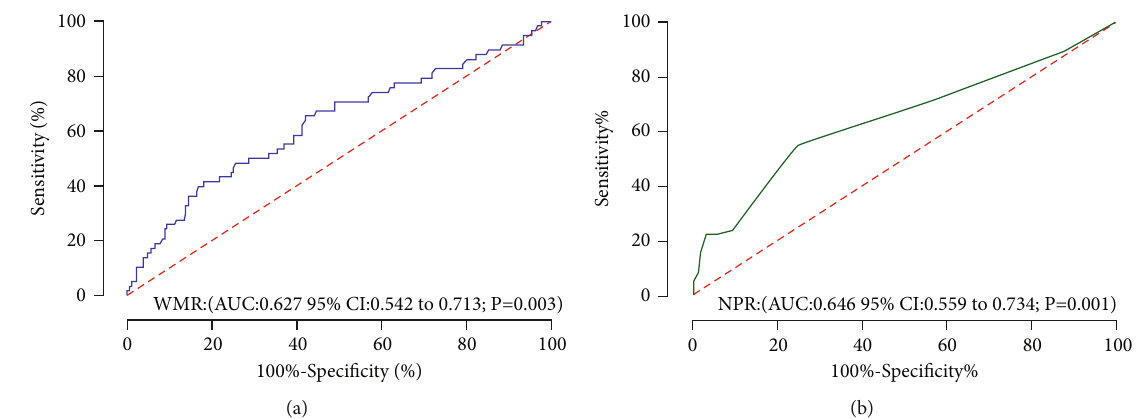
Figure 6: Receiver operating characteristic (ROC) curve of the ability of WMR (a) and NPR (b) to predict MACE in MINOCA patients. AUC: area under the curve; CI: con fi dence interval; WMR: white blood cell count to mean platelet volume ratio; NPR: neutrophil-to- platelet